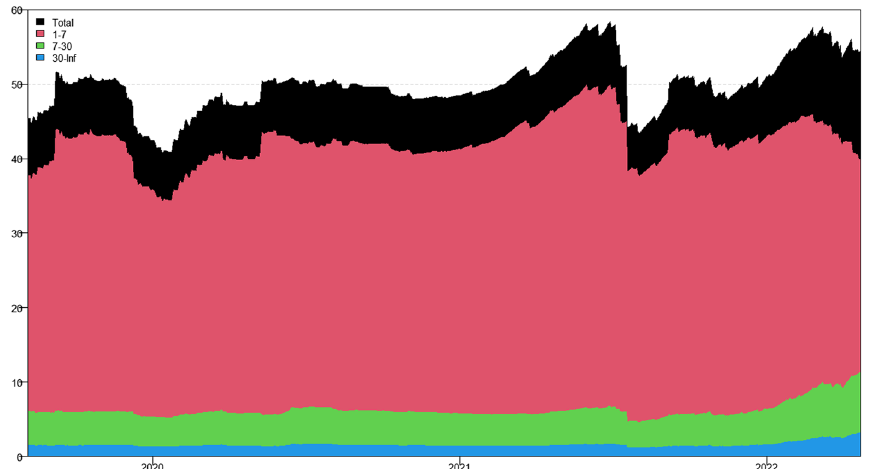
Fig. 10 Dynamic total connectedness—realized kurtosis